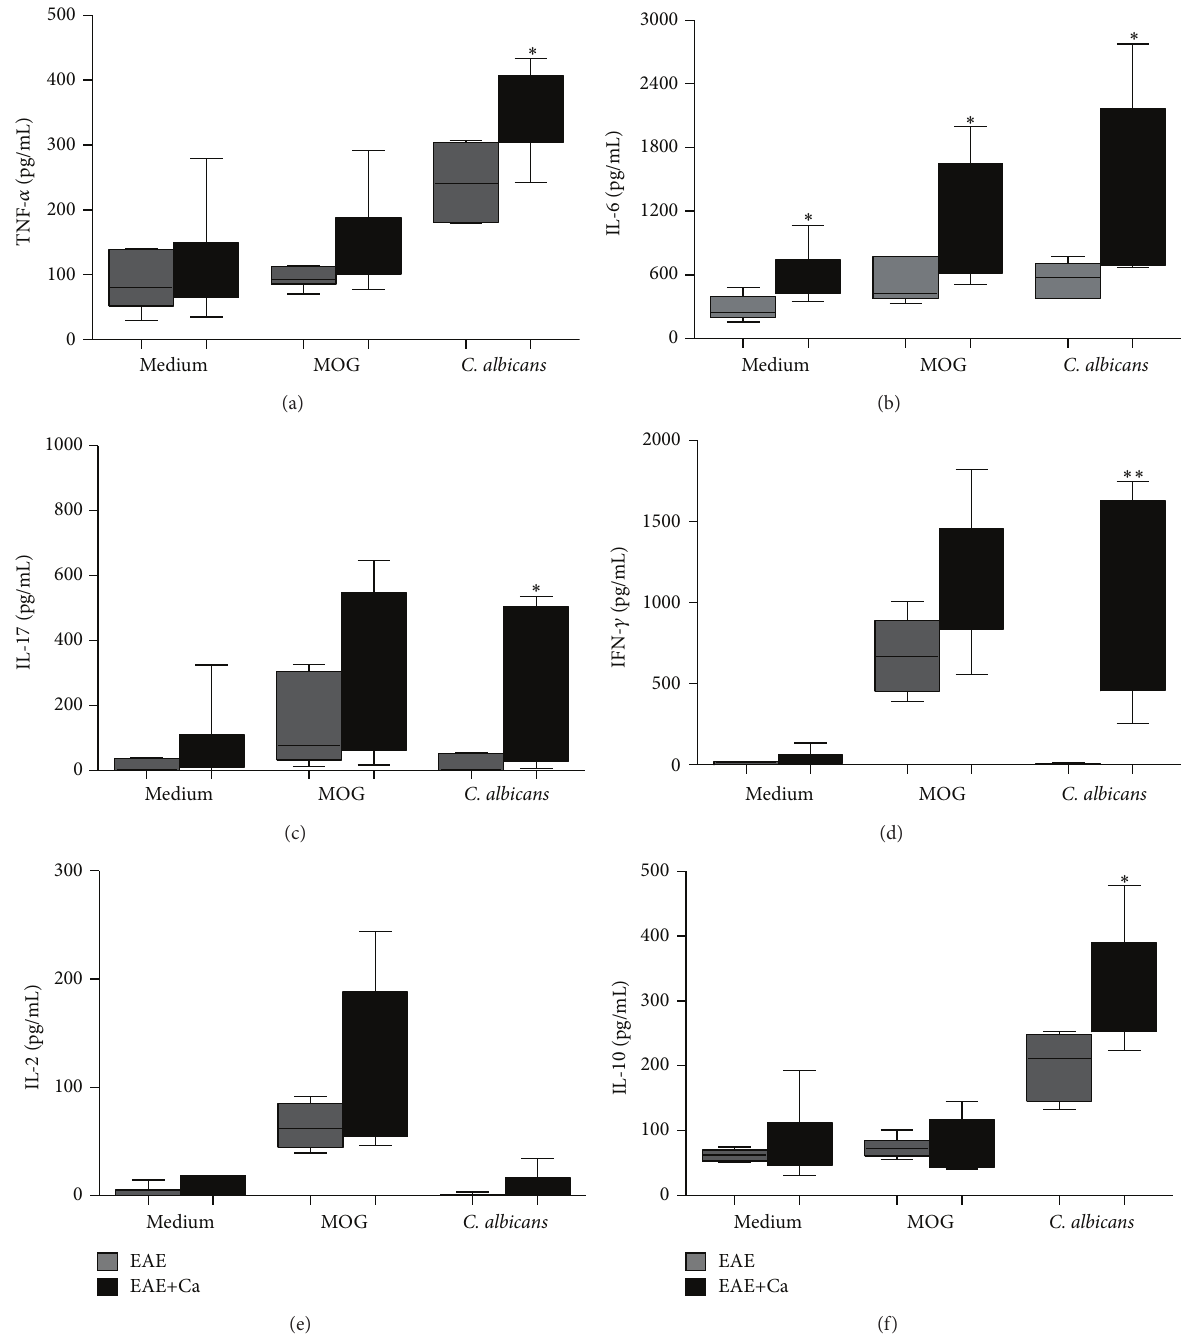
Figure 6: Candida specific T cells contribute to elevated production of encephalitogenic cytokines in the CNS. CNS eluted cells were restimulated with MOG or heat-killed C. albicans and TNF- 𝛼 (a), IL-6 (b), IL-17 (c), IFN- 𝛾 (d), IL-2 (e), and IL-10 (f) levels were measured by ELISA. The results are expressed as median, 25–75% (box), and minimum-maximum (error bars) of 6 to 7 mice/group. Mann-Whitney test, ∗ 𝑃 < 0.05 and ∗∗ 𝑃 < 0.01 indicate statistical difference between EAE and EAE+Ca groups under the same in vitro